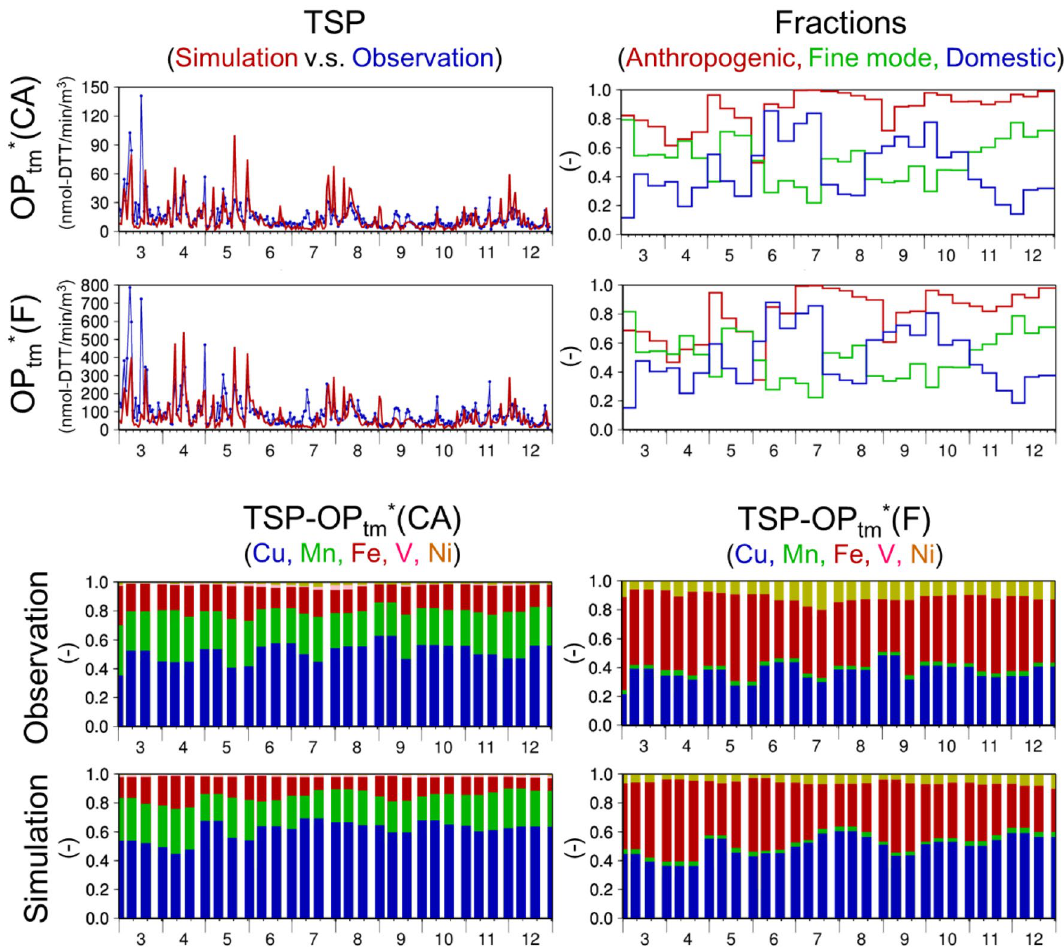
Figure 2. Temporal variations in the daily OP tm *(CA) and OP tm *(F) and fractions of anthropogenic vs natural compounds, fine vs coarse particles, domestic vs transboundary contributions, and DTT-active elements. Temporal variations in (upper-left panels) the daily OP tm *(CA) and OP tm *(F) based on (red) the simulated (D01) and (blue) observed transition metals in TSP (nmol-DTT min −1 m −3 ), (upper-right panels) 10-d mean simulated (D02) fractions of (red) anthropogenic compounds to the total compounds, (green) anthropogenic fine-mode particles to anthropogenic total particles, and (blue) anthropogenic domestic contributions to the total OP tm *(CA) and OP tm *(F), (lower-left panels) relative contributions of each metal to the observed and simulated OP tm *(CA) and (lower-right panels) same as the lower-left panels but for OP tm *(F) at Yonago. Note that the simulated concentration of TSP is equivalent to the simulated PM 10 concentration.